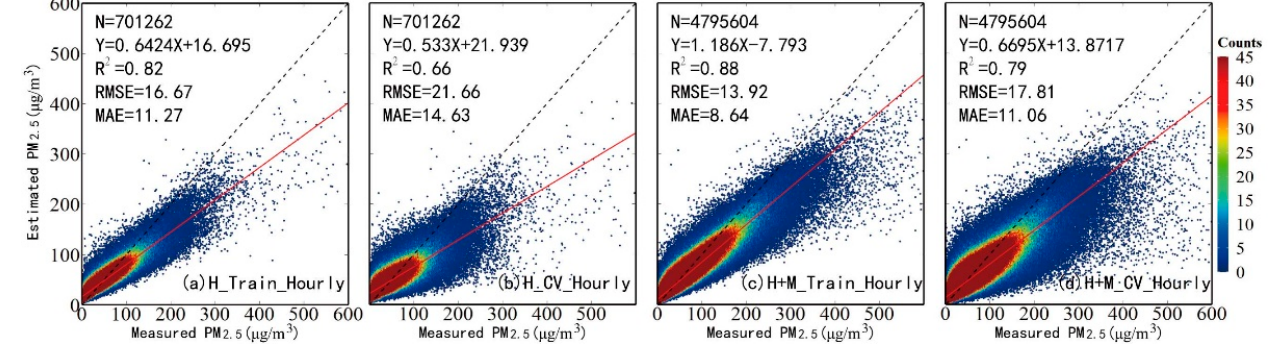
Figure 2. Density scatterplots of model fitting and 10-fold cross-validation for evaluating the model performance.